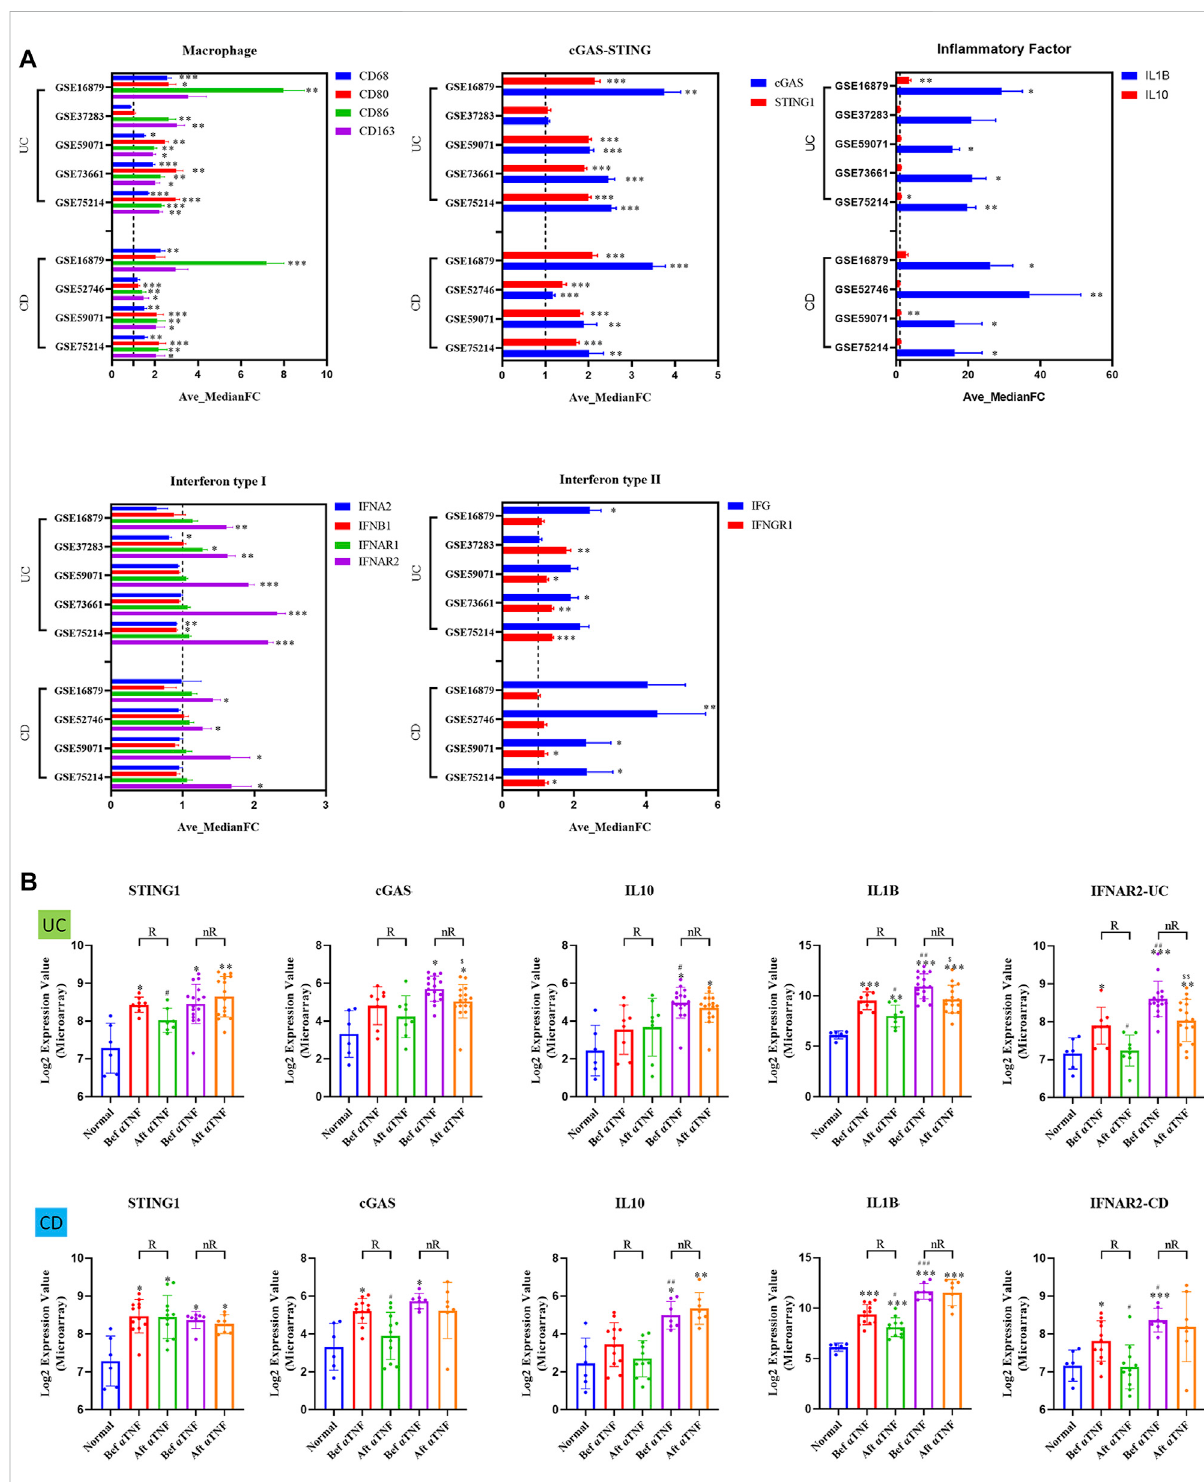
FIGURE 4 The up-regulation of gene expression of cGAS-STING pathways in IBD patients, including UC and CD. (A) The relative expression changes of macrophage cGAS-STING signaling pathway in IBD patients. (B) The mRNA levels of cGAS-STING signaling pathway in UC and CD responder/non- responder patients, before and after treatment of anti-TNF (in fl iximab), compared with non-IBD controls. R., anti-TNF responders; nR., anti-TNF non-responders; Bef α TNF, before anti-TNF treatment; Aft α TNF, after anti-TNF treatment. All data are shown as mean ± SD and are analyzed using one-way ANOVA followed by Dunnett ’ s multiple comparison test. UC, ulcerative colitis; CD, Crohn ’ s